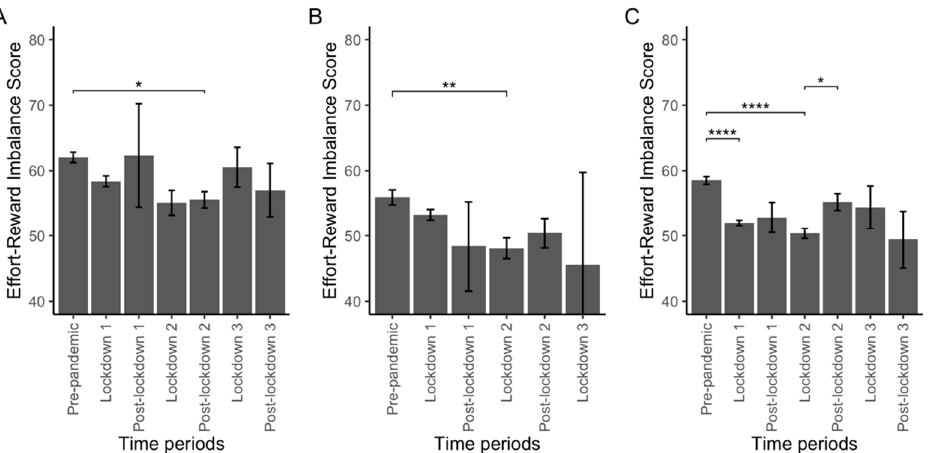
Figure 3. Effort-Reward Imbalance (ERI) score across the periods of interest according to occupations. Plot ( A ): in medical professionals, Plot ( B ): in paramedical professionals, Plot ( C ): in other workers. Abbreviations: *: <0.05; **: <0.01; ****: <0.0001.